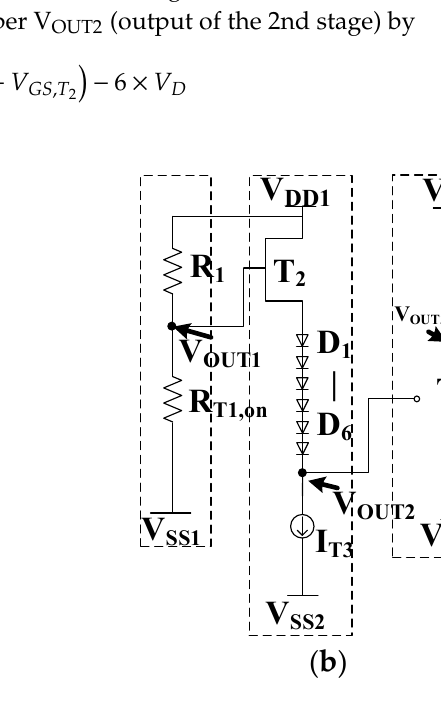
source which means the V GS of T 3 is zero so that T 3 will maintain the ON state and the bias current can be figured out by